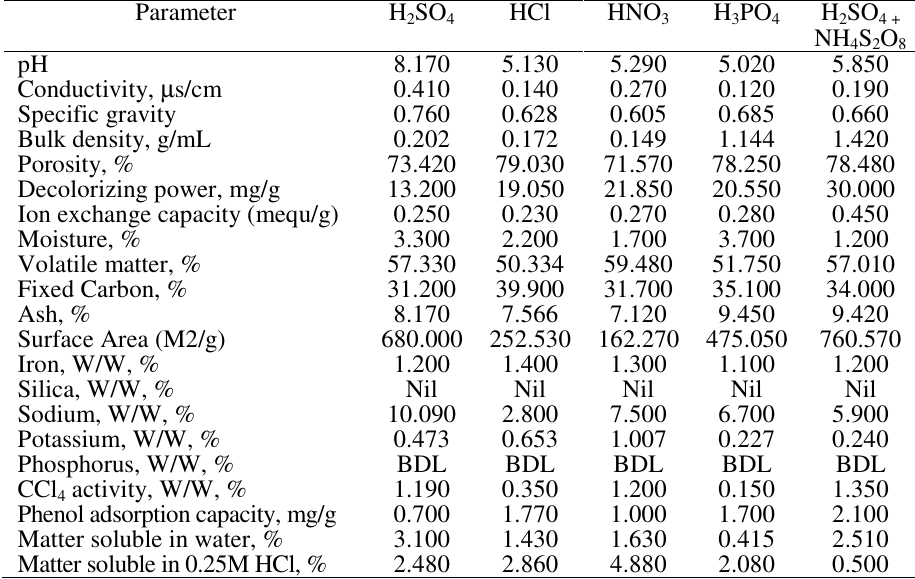
Table 3. Characteristics of Parthenium activated carbon prepared